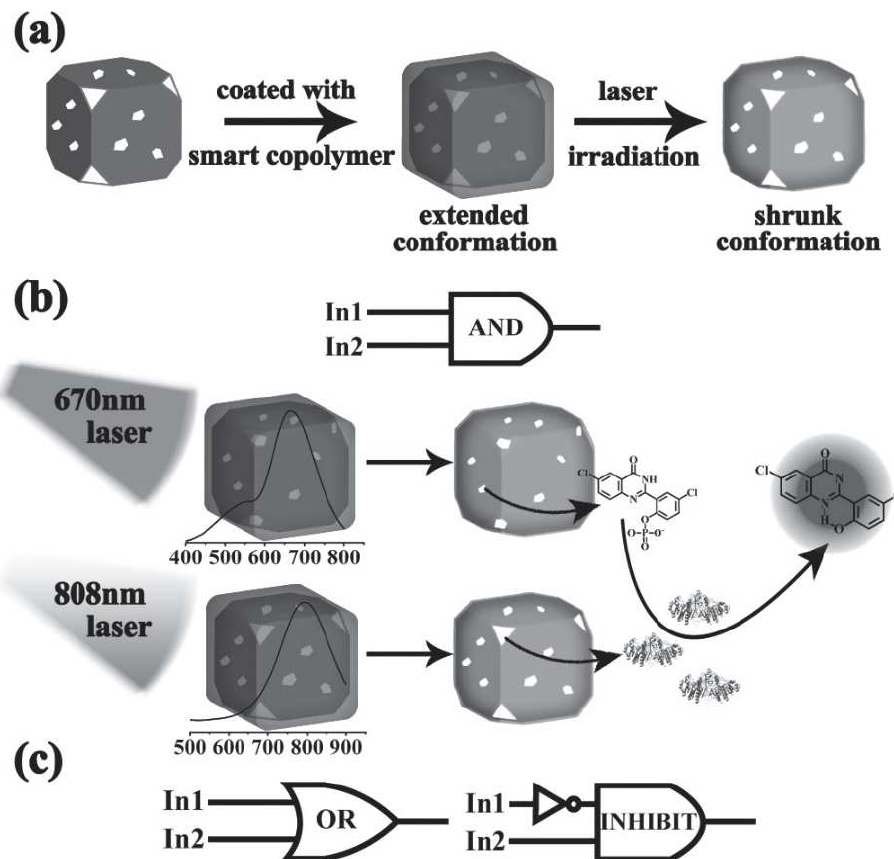
Figure 10. ( a ) Illustration of light-responsive AuNC copolymer. ( b , c ) Schematic diagram of two wavelengths of light (808 nm and 670 nm)-encoded logic gates for controlled release based on